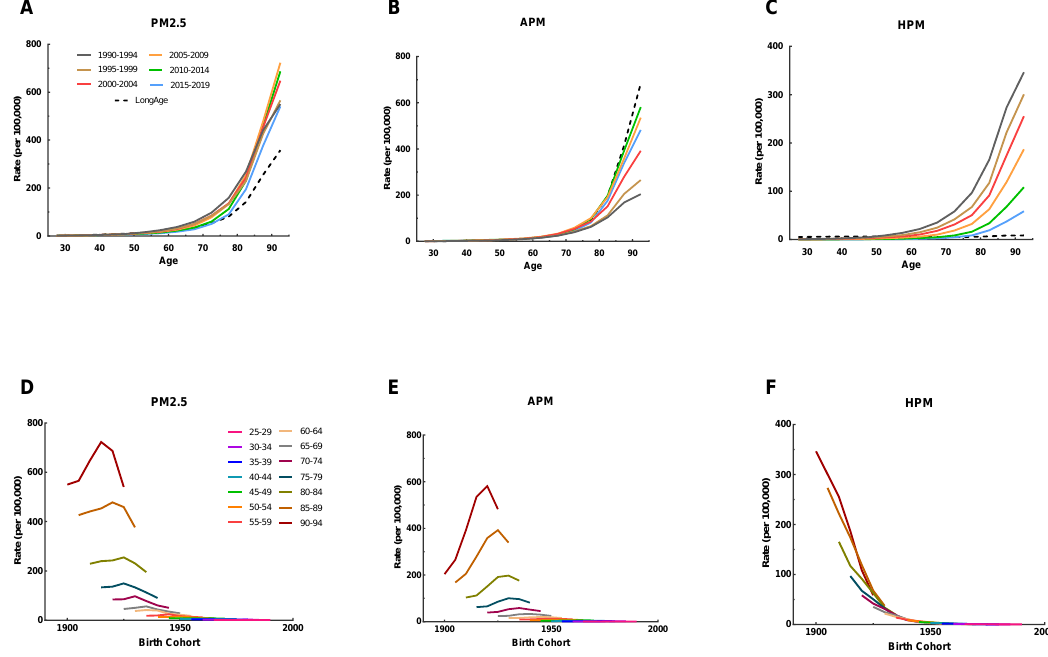
Figure 1. The age-specific mortality rates of IHD attributable to PM 2.5 (APM and HPM) by period between 1990 and 2019 and cohort-specific mortality rate of IHD attributable to PM2.5 by age group between 1990 and 2019. ( A – C ) Survey years were arranged into consecutive 5-year periods from 1990 to 1994 (median, 1992), 1995 to 1999 (median, 1997), 2000 to 2004 (median, 2002), 2005 to 2009 (median, 2007), 2010 to 2014 (median, 2012), and 2015 to 2019 (median, 2017). Longitudinal age curves were estimated by the age – period – cohort model and indicated the expected age-specific rate of IHD mortality due to PM 2 . 5 (APM and HPM). ( D – F ) The data of IHD mortality attributable to PM 2 . 5 (APM and HPM) were arranged into 19 consecutive birth cohorts, including those born from 1898–1902 (median, 1900) to 1988–1992 (median, 1990), and successive 5-year age intervals from 25–29 years (median, 27 years) to 90–94 years (median, 92 years) of age.